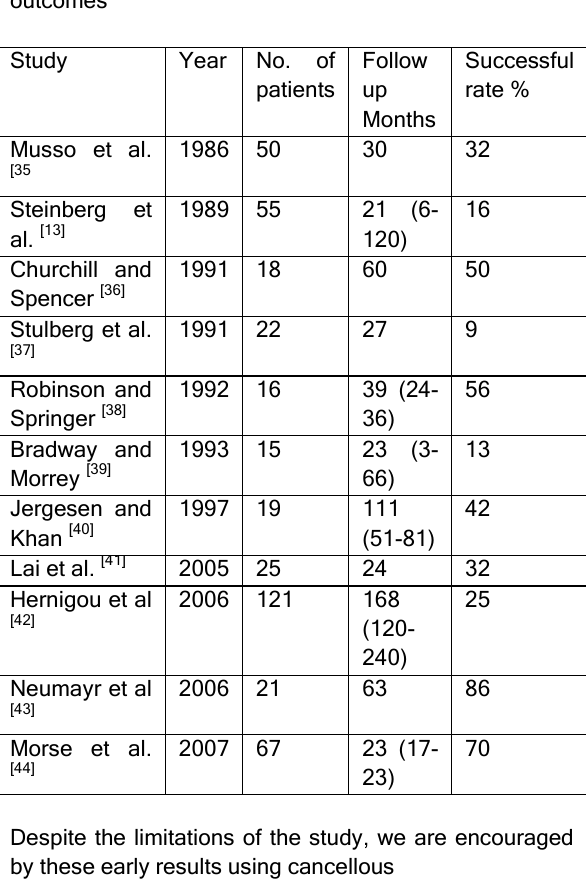
Table 6. Literature review of decompression treatment